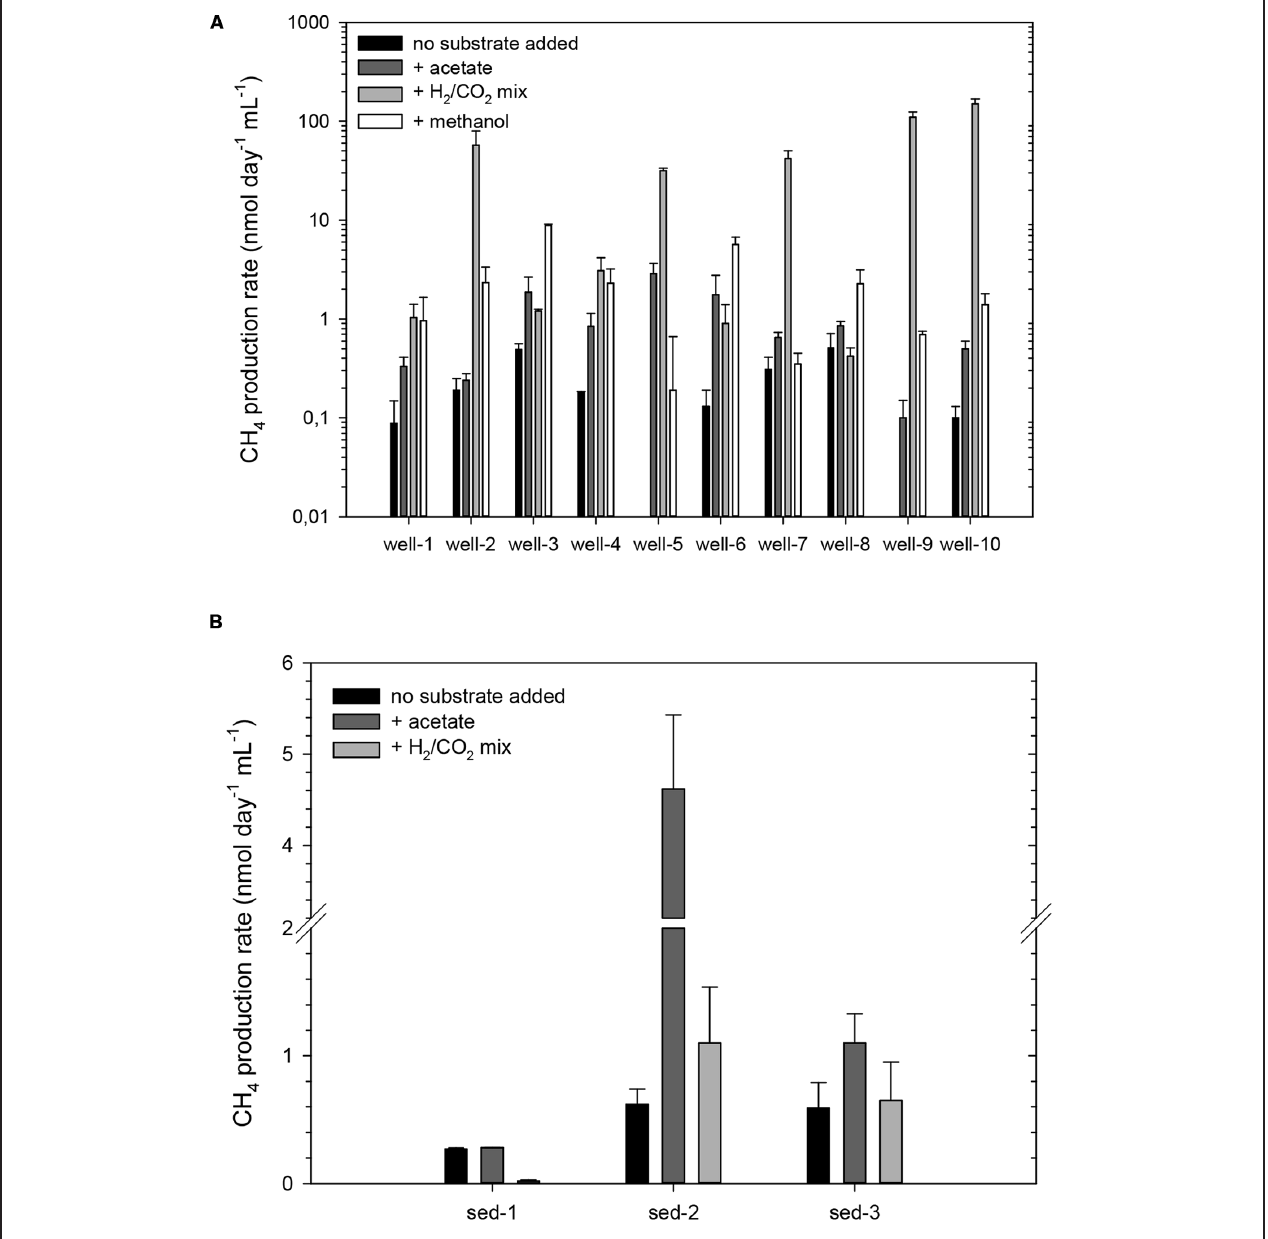
added or amended with either acetate, or a mixture of H 2 and CO 2 (B). Notice the different scale of the Y axis. The error bars represent the SD of three replicates. All cultures were incubated at 30 ◦ C for 73